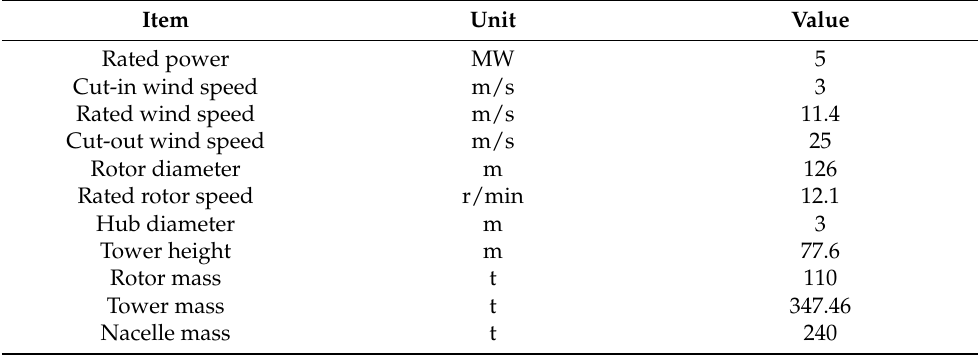
Table 1. Parameters of the NREL 5 MW baseline wind turbine.